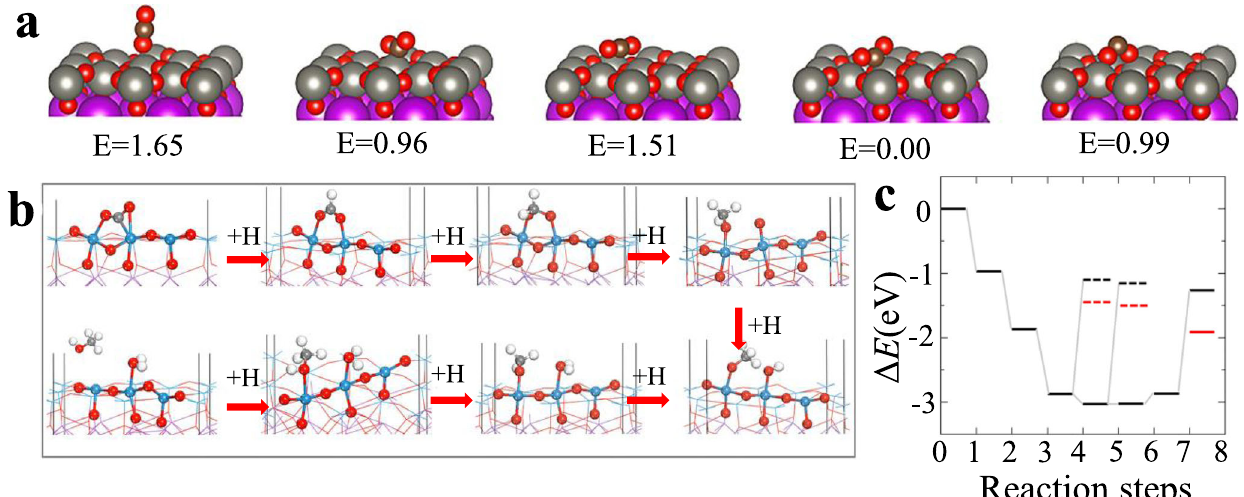
Fig. 4 Adsorption con fi gurations and reaction path of CO 2 into CH 3 OH on Bi 2 WO 6 . a Five different adsorption con fi gurations for CO 2 on Bi 2 WO 6 . The red, gray, purple, and brown spheres stands for O, W, Bi, and C atoms. b Structures and c reaction energies for the CO 2 reduction. Eight reaction steps are considered. The red, cyan, light gray, and dark gray spheres stand for O, W, H, and C atoms. Only the atoms around CO 2 are highlighted. The reaction energies for the side product (methanol) at steps “ 4 ” and “ 5 ” are indicated by short dashed lines. The short red (dashed) lines are estimated from the free